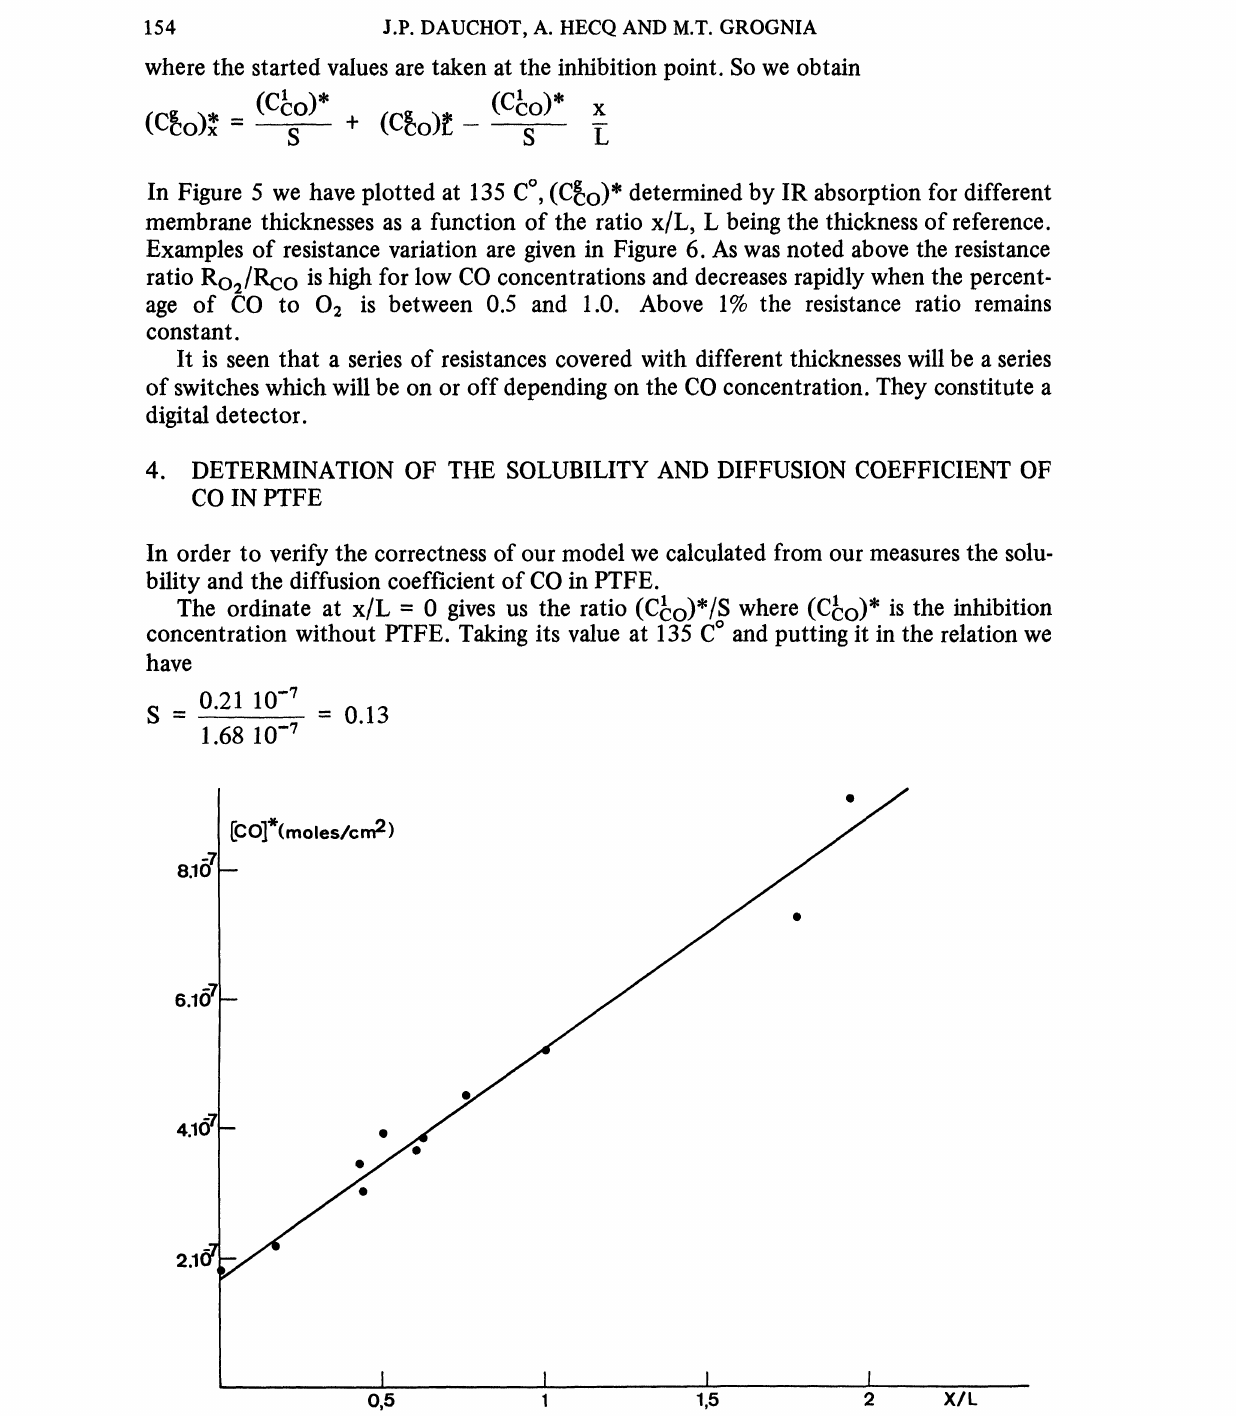
FIGURE 5 Plot of (Co)* as a function of membrane thickness (L 1800